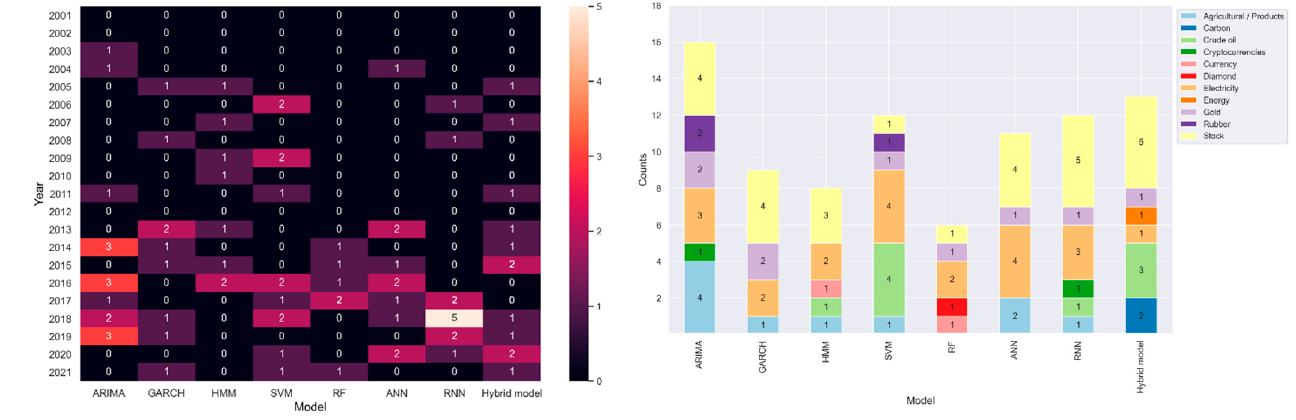
Figure 2. The evolution of time-series forecasting models in different domains over two decades.